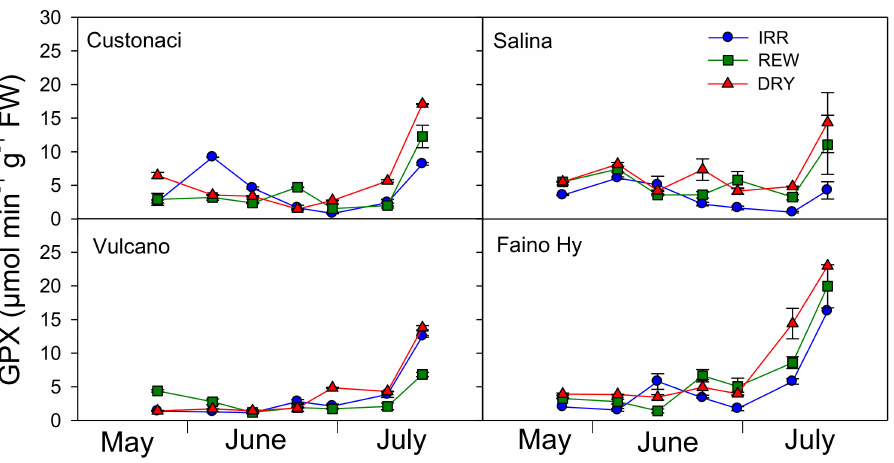
Figure 7. Glutathione peroxidase activity (GPX, µ mol min − 1 g − 1 FW) in four genotypes of tomato in relation to the irrigation treatment (IRR: full irrigation; REW: rewatering; DRY: no irrigation). Vertical bars indicate the standard error ( n =